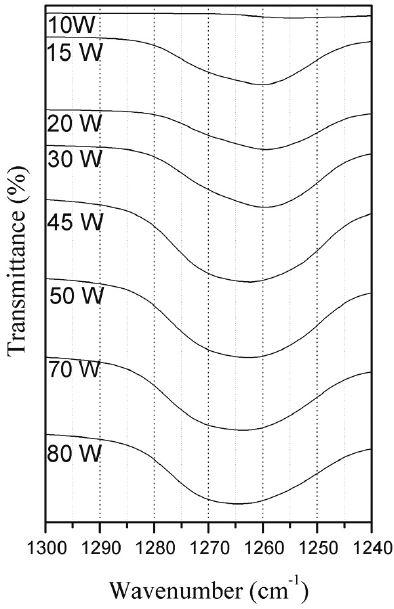
Figure 5. Infrared spectra of the films deposited with powers ranging from 10 to 80 W in the region between 1300 and 1240 cm –1 .